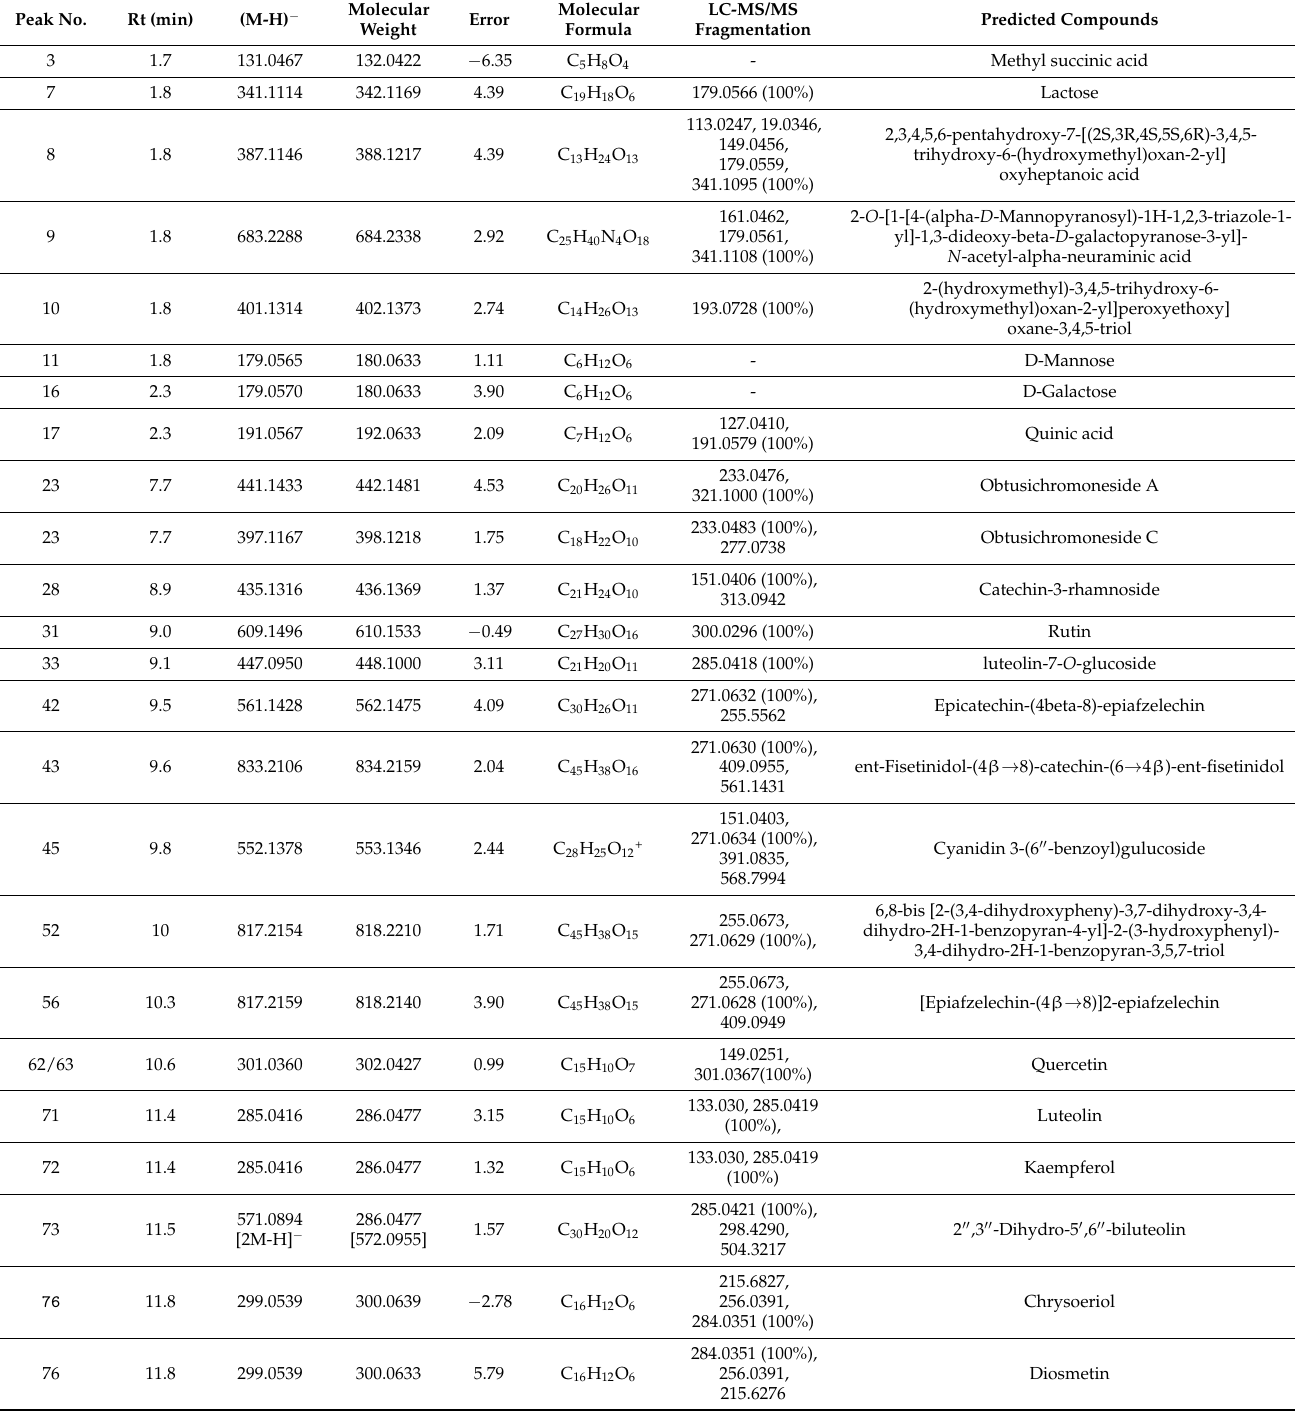
Table 2. Liquid chromatography–tandem mass spectrometry (LC–MS/MS) of ethanolic extract Cassia timoriensis .